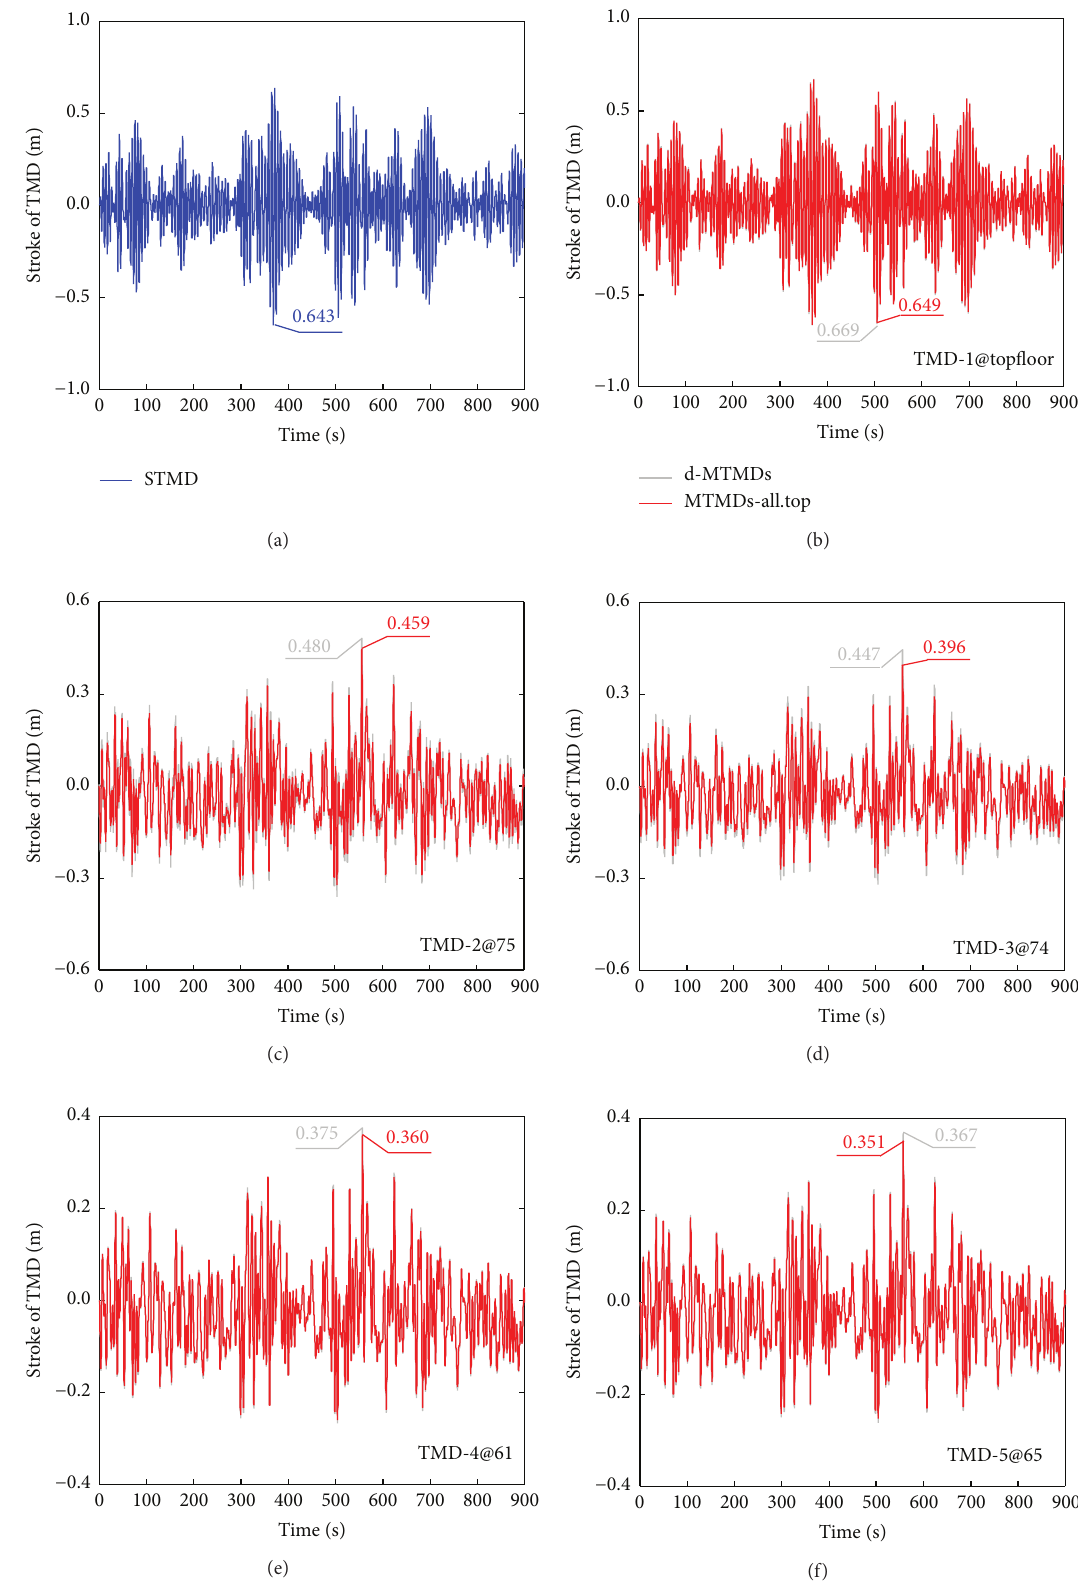
Figure 7: Time variation of the strokes of the STMD, MTMDs, and